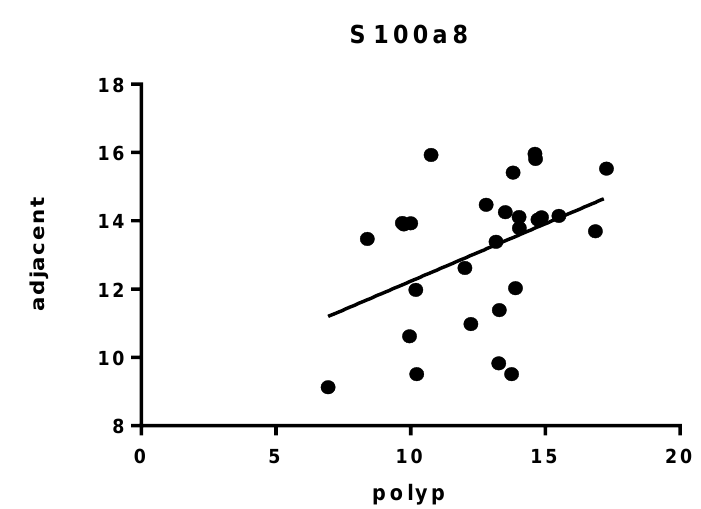
Figure 5. S100A8 correlation expression between polyp and adjacent tissue. Data are expressed as ΔCt.